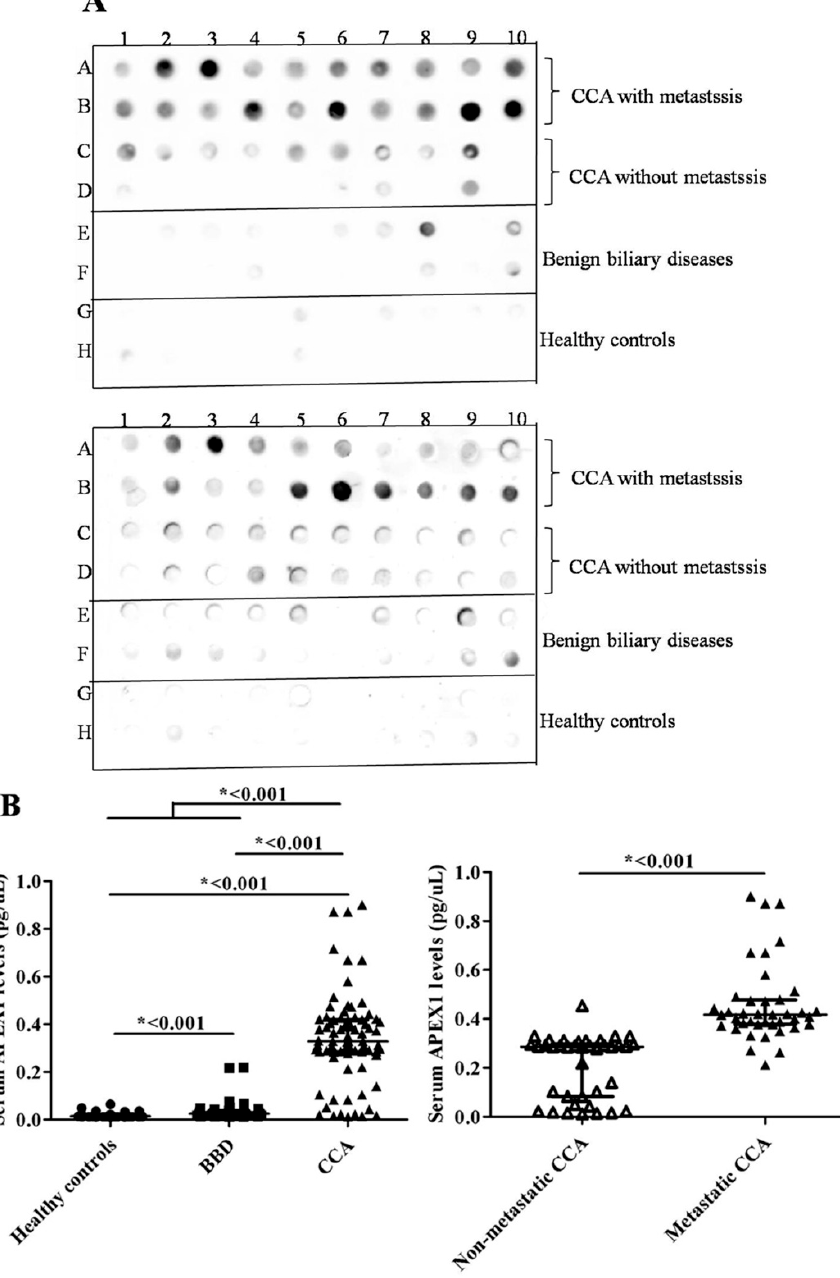
Table 2. The overview of ROC curve evaluation of APEX1 as a diagnostic marker for CCA.